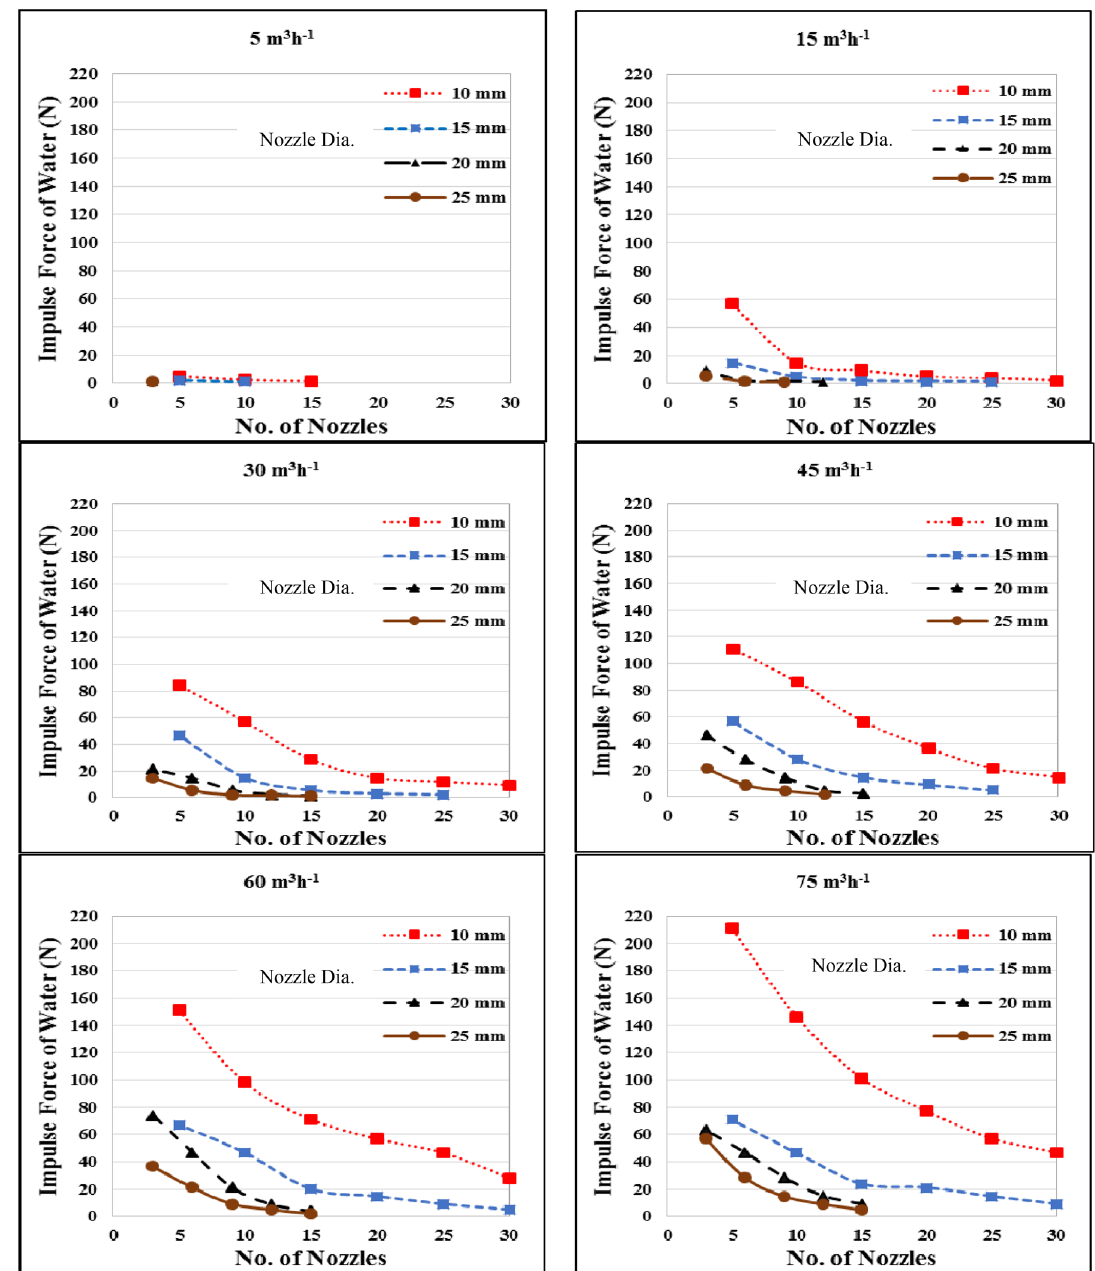
Figure 4. Effect of flow rate, nozzle diameter and number of nozzles on the impulse force of water in a circular At 30 m 3 h −1 flow rate, the highest value of the average velocity of water 18.51 cm s −1 was found for 5 nozzles and 10 mm nozzle diameter. While, the lowest value of the average velocity of water was 4.65 cm s −1 was found for 12 nozzles and 25 mm nozzle diameter. At 45 m 3 h −1 flow rate, the average velocity of water ranged from 6.66 to 23.26 for all treatments under study, also, at 60 m 3 h −1 flow rate, the average velocity of water ranged from 9.23 to 34.82 for all treatments under study. At 75 m 3 h −1 flow rate, the average velocity of water ranged from 10.00 to 48.76 for all treatment of this study. The results also indicate that the highest value of the average velocity of water 48.76 cm s −1 was found for 5 nozzles and 10 mm nozzle diameter at 75 m 3 h −1 flow rate, respectively. While, the lowest value of the average velocity of water was 1.07 cm s −1 was found for 10 nozzles and 15 mm nozzle diameter at 5 m 3 h −1 flow rate, respectively. These results agreed with those obtained by 18,20 . Fish distribution in the circular tank is influenced by the heterogeneity of water velocity in the area between inlet flow and the center of the tank 9 . Fish distribution in the circular tank is mostly concentrated in the area between high and low velocity area. The high velocity area